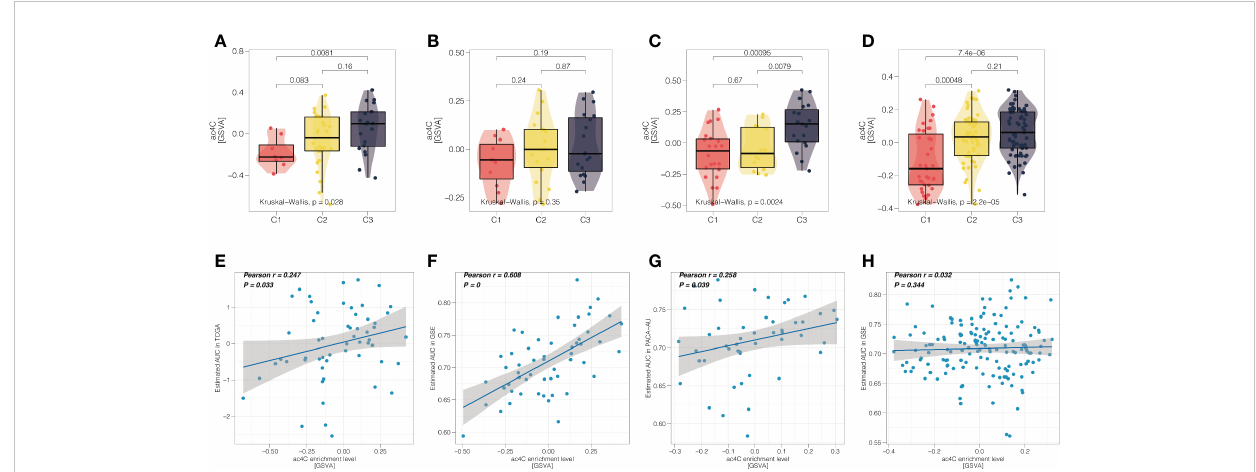
FIGURE 7 NAT10-relevant resistance to gemcitabine in PDAC. Distribution of single-sample enrichment score of NAT10 in three PDAC subtypes for the (A) TCGA cohort, (B) GEO cohort, (C) PACA_AU cohort, and (D) E-MTAB-6134 cohort, respectively. (D) Scatter correlation plot showing the Pearson ’ s correlation between the NAT10 enrichment score (x-axis) and predicted AUC of gemcitabine (y-axis) for the (E) TCGA cohort, (F) GEO cohort, (G) PACA_AU cohort, and (H) E-MTAB-6134 cohort, respectively.